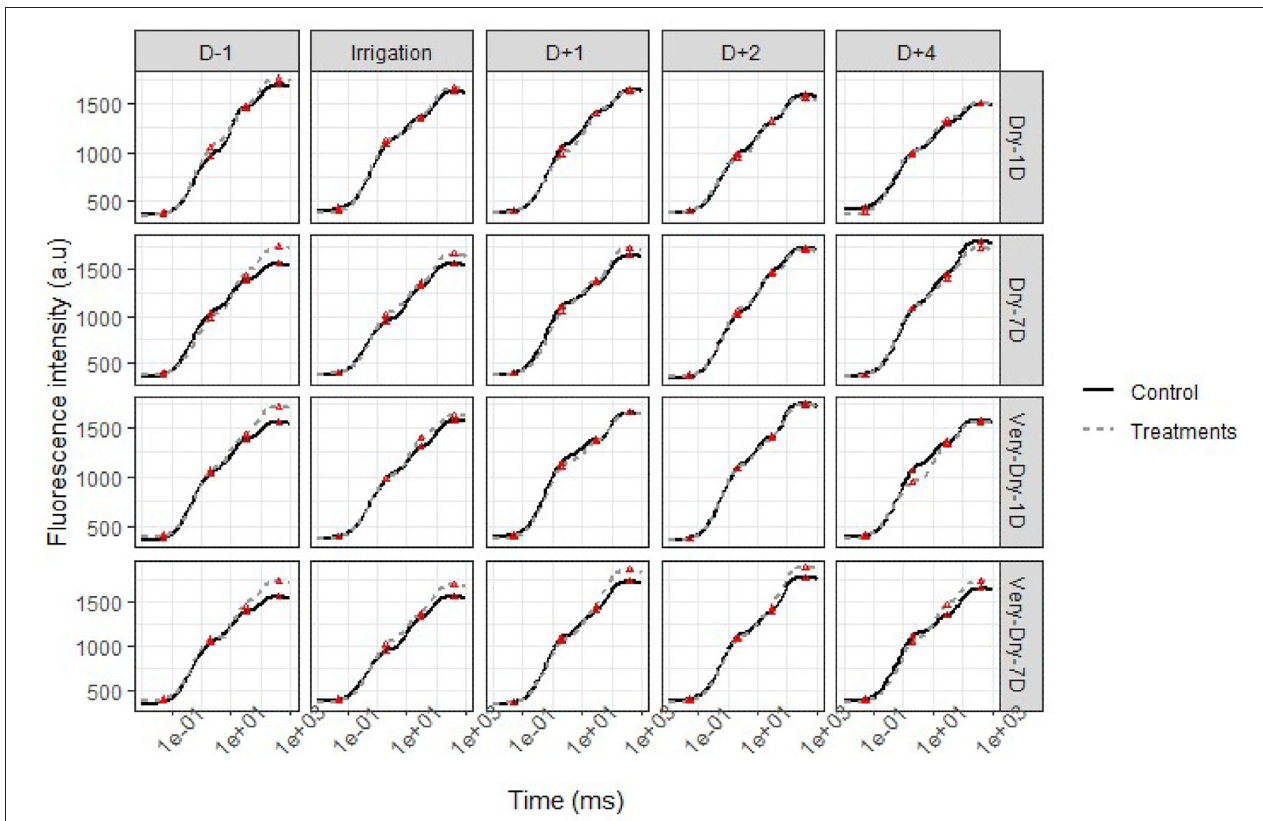
FIGURE 6 | OJIP transient curves of chlorophyll a fluorescence for potato under stress (solid lines) and optimal water supply (dashed lines) conditions–second stress in the summer 2019 experiment. Each point represents the mean of four independent measurements. The red triangles ( 1 ) denote the position of the OJIP points on the